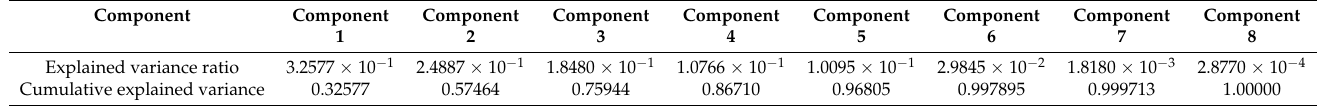
Table 2. Result of Principal Component Analysis